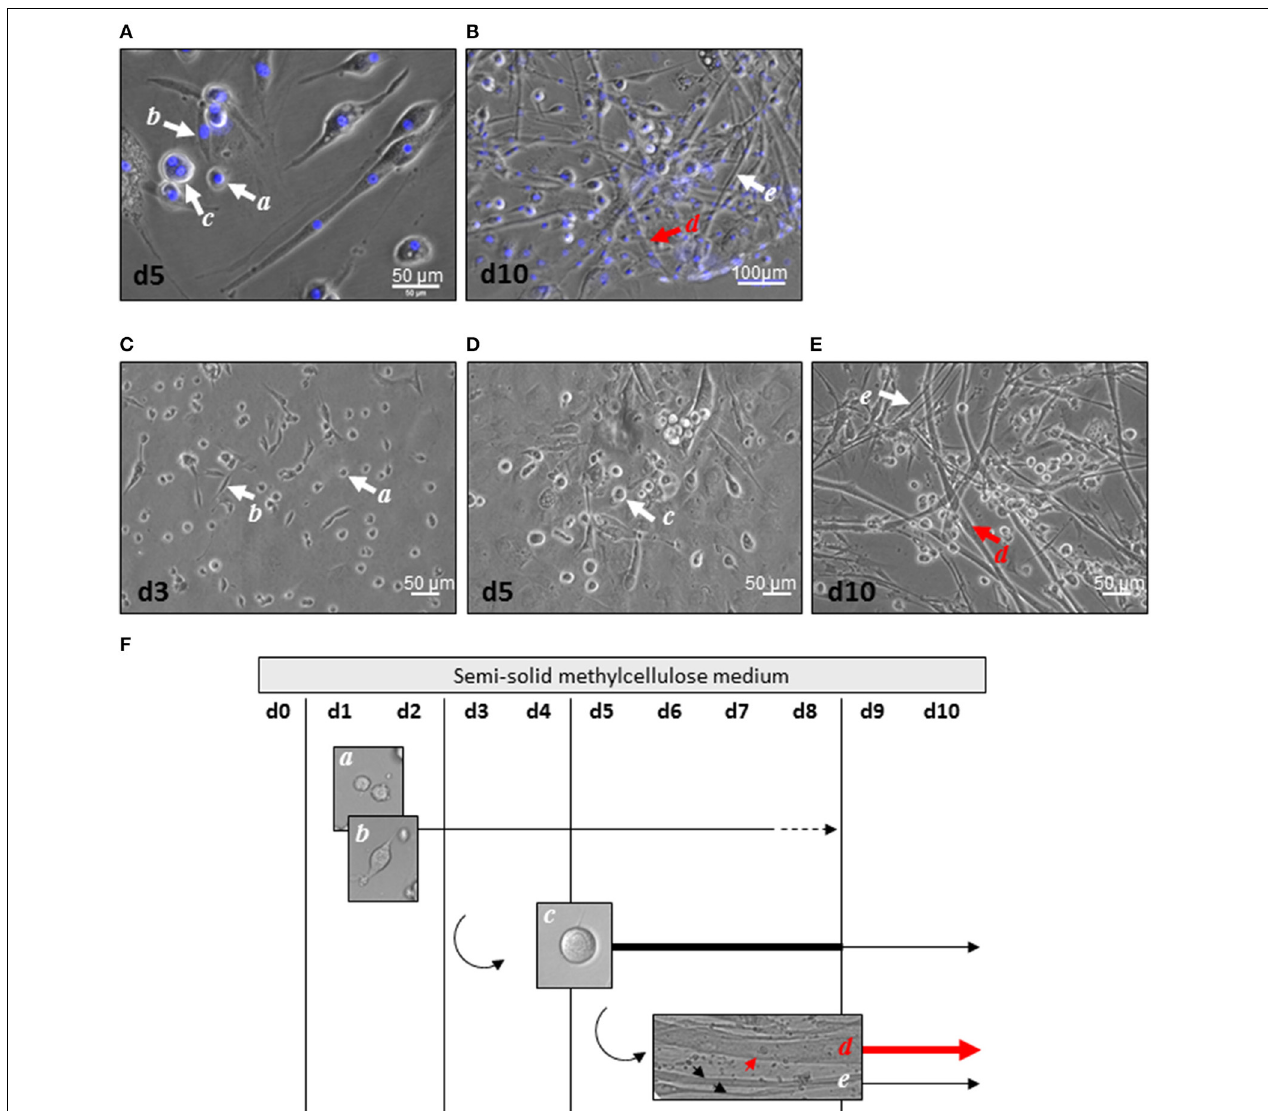
FIGURE 1 | Cell heterogeneity in myogenic clusters. (A,B) After 5 days (A) and 10 days (B) of culture, AD-CMG displayed mono and multi-nucleation associated to various morphologies: small round mono-nucleated cells ( a cells), bipolar mono-nucleated cells ( b cells), large round multi-nucleated cells ( c cells), thick multi-nucleated tube-shaped cells ( d cells), and thin multi-nucleated tube-shaped cells ( e cells). Nuclei were stained with Dapi